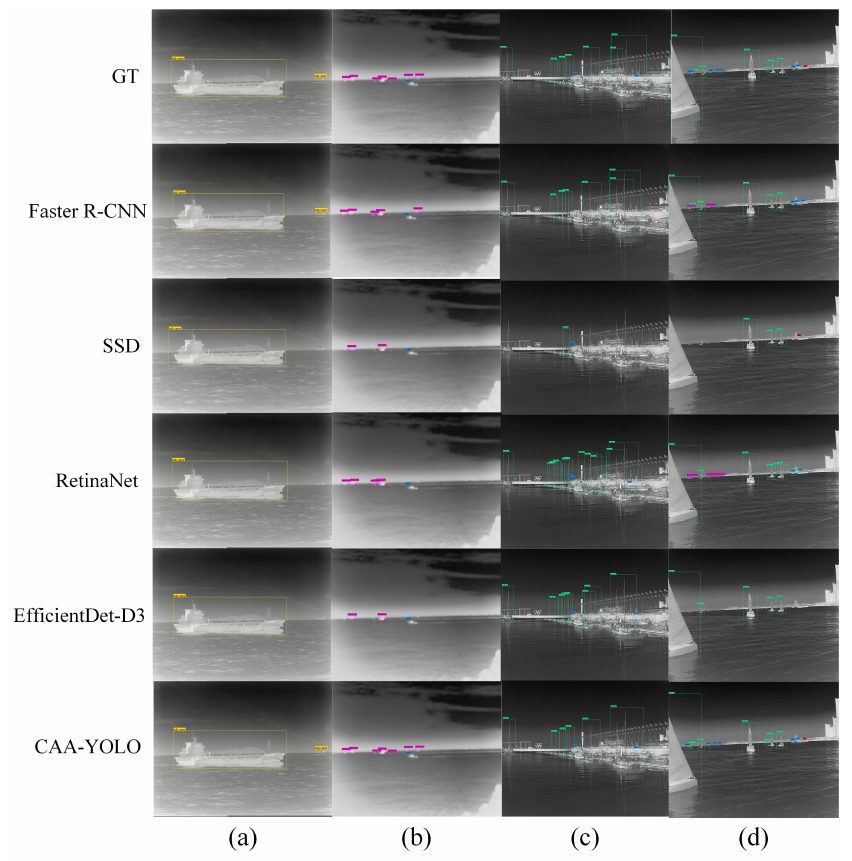
Figure 16. The infrared ship detection results of different methods. GT represents the ground truth box, the second to sixth lines represent the detection results of faster R-CNN, SSD, RetinaNet, EfficientDet-D3 and CAA-YOLO, respectively. ( a – d ) represents the 4 groups of detection